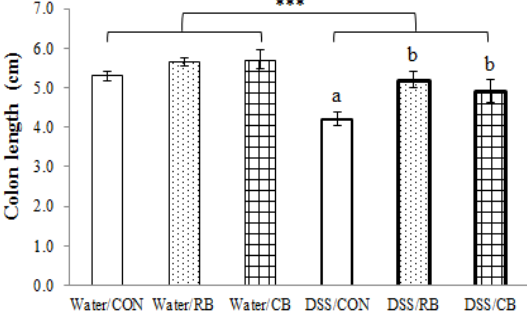
Figure 3. The effect of diet and dextran sulfate sodium (DSS) on colon length. Diet groups are tap water and control (Water/CON), tap water and 10% raw broccoli (Water/RB), tap water and 10% lightly cooked broccoli (Water/CB), DSS and control (DSS/CON), DSS and 10% raw broccoli (DSS/RB), and DSS and 10% lightly cooked broccoli (DSS/CB). Data are mean ± SE ( n = 6, except for DSS/RB, n = 5). *** indicates a significant effect of DSS, p < 0.001. The presence of letters indicates a significant effect of diet for Water groups or DSS groups ( p < 0.05). Values with the same letter are not different ( p < 0.05).